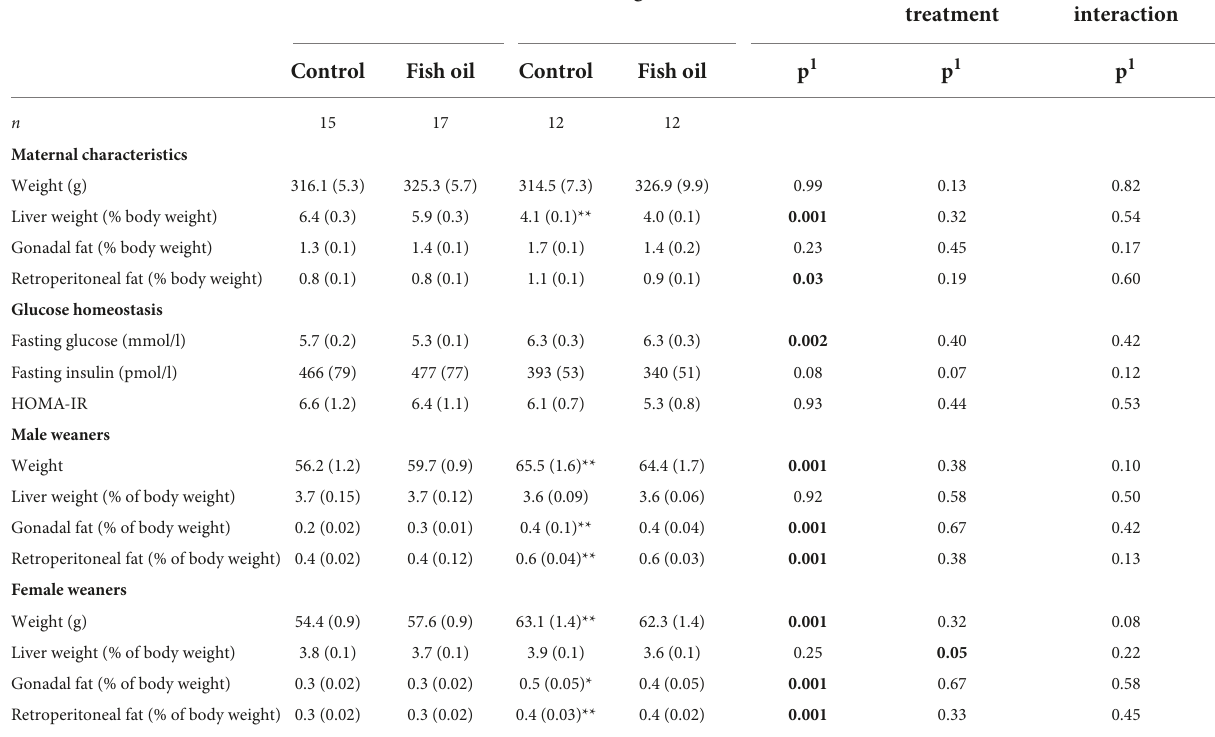
TABLE 5 Characteristics of mothers and weaners culled on postnatal day 21 according to the maternal diet (control or high-fat diet) and the fish supplementation during pregnancy [fish oil or control (no oil gel)]. Maternal control diet Maternal high-fat diet Effect of diet Effect of treatment